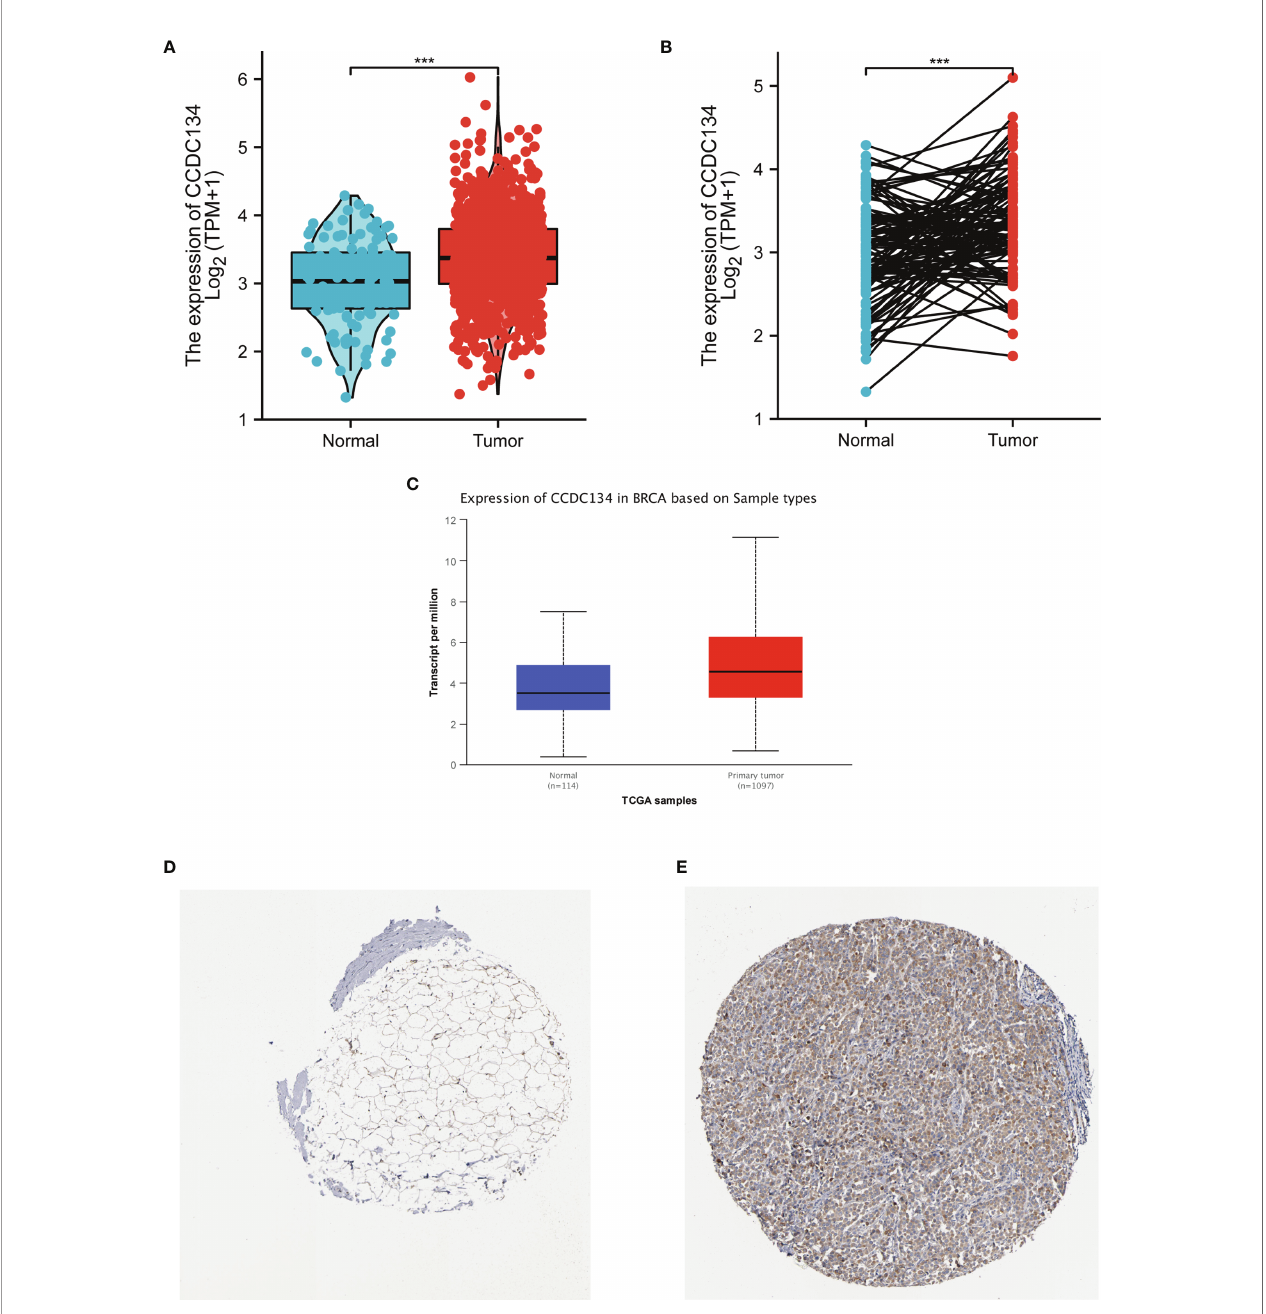
FIGURE 2 | CCDC134 mRNA and protein expression in breast cancer. (A) CCDC134 mRNA expression levels in 1109 breast and 113 normal breast cancers. (B) CCDC134 mRNA expression levels in 112 breast cancer patients and matched adjacent normal samples. (C) CCDC134 protein expression level based on CPTAC. (D) CCDC134 protein levels based on Human Protein Atlas. Normal tissue, https://www.proteinatlas.org/ENSG00000100147-CCDC134/tissue/breast#img; (E) Tumor tissue, https://www.proteinatlas.org/ENSG00000100147-CCDC134/pathology/breast+cancer#img.